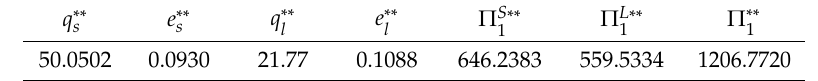
Table 2. Supply chain network benefit equilibrium variables under speculative